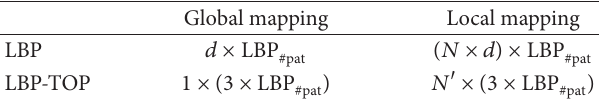
Table 3: Size of a descriptor for an SD-OCT volume. 𝑑 denotes the number of slices in the volume, 𝑁 the number of 2D windows, and 𝑁 󸀠 the number of 3D subvolumes,